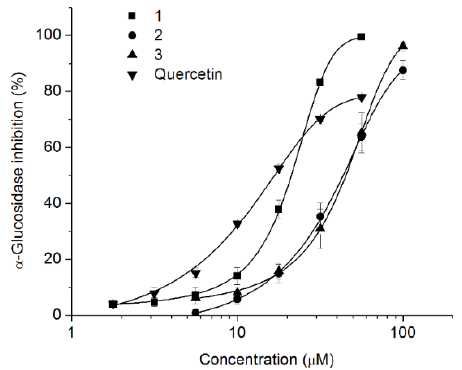
Figure 7. Concentration-response evaluation of compounds 1 – 3 isolated from S. cinnabarina on yeast α -glucosidase inhibition. Each value represents the mean of three independent experiments ± SEM; The data were analyzed by ANOVA followed by Dunnet post hoc test for comparison with control group.